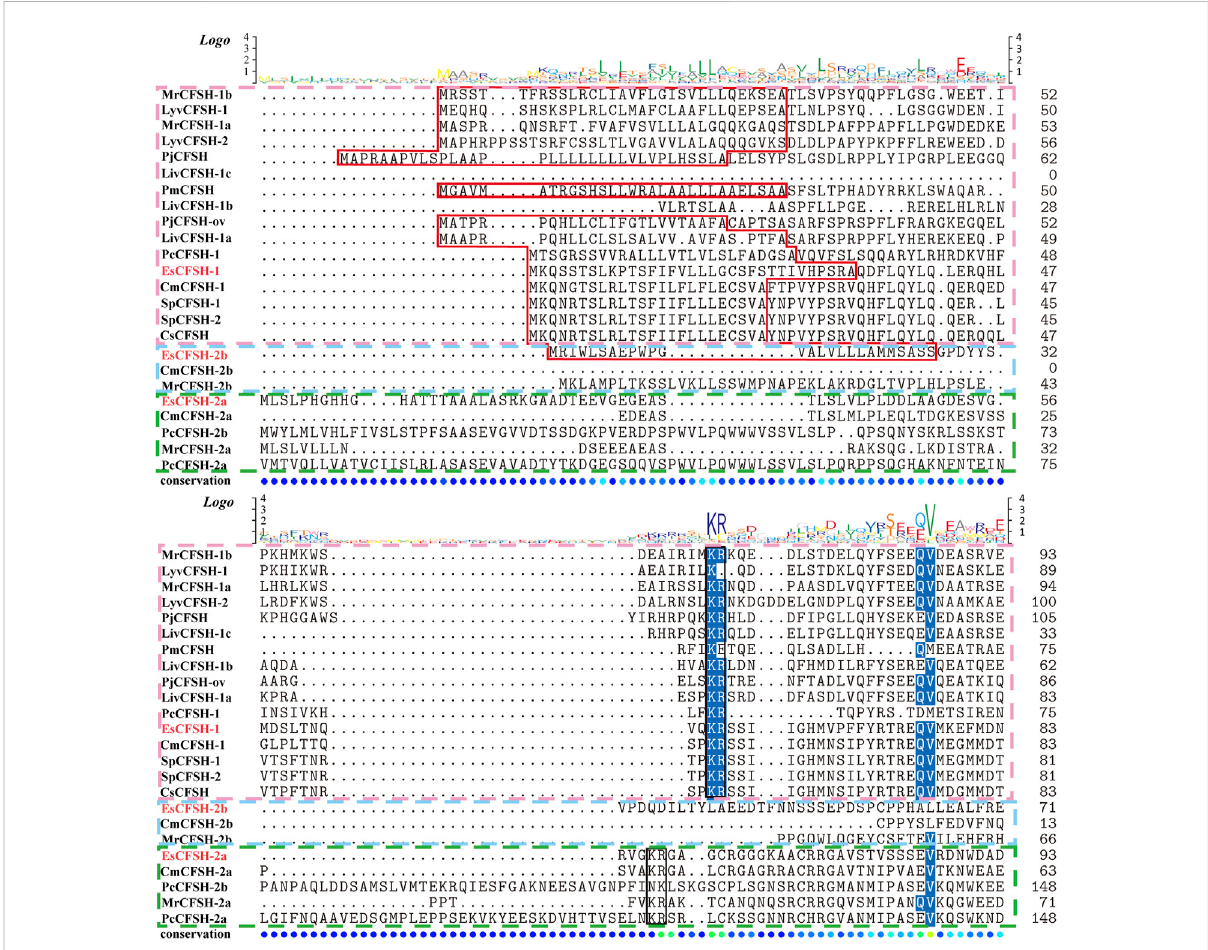
FIGURE 2 ThemultiplesequencealignmentanalysisoftheaminoacidofdecapodCFSHs.ThreesubtypesofCFSHswereboxed,thepinkboxwasCFSH1, the light blue was CFSH 2b, and the green was CFSH 2a. The signal peptide was outlined by the red frame, and the cleavage site was boxed in black line, the conserved cysteine residues were marked with red